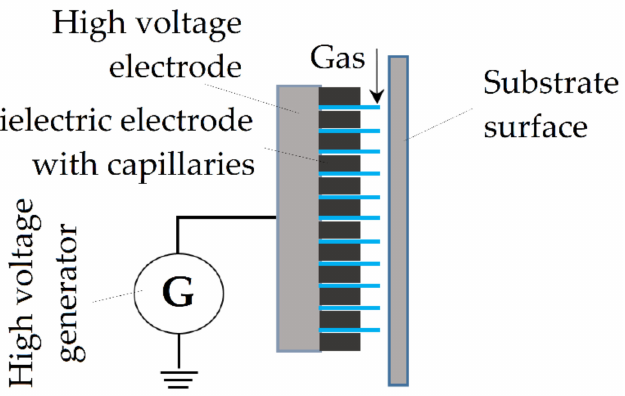
Figure 5. Capillary discharge device used for surface